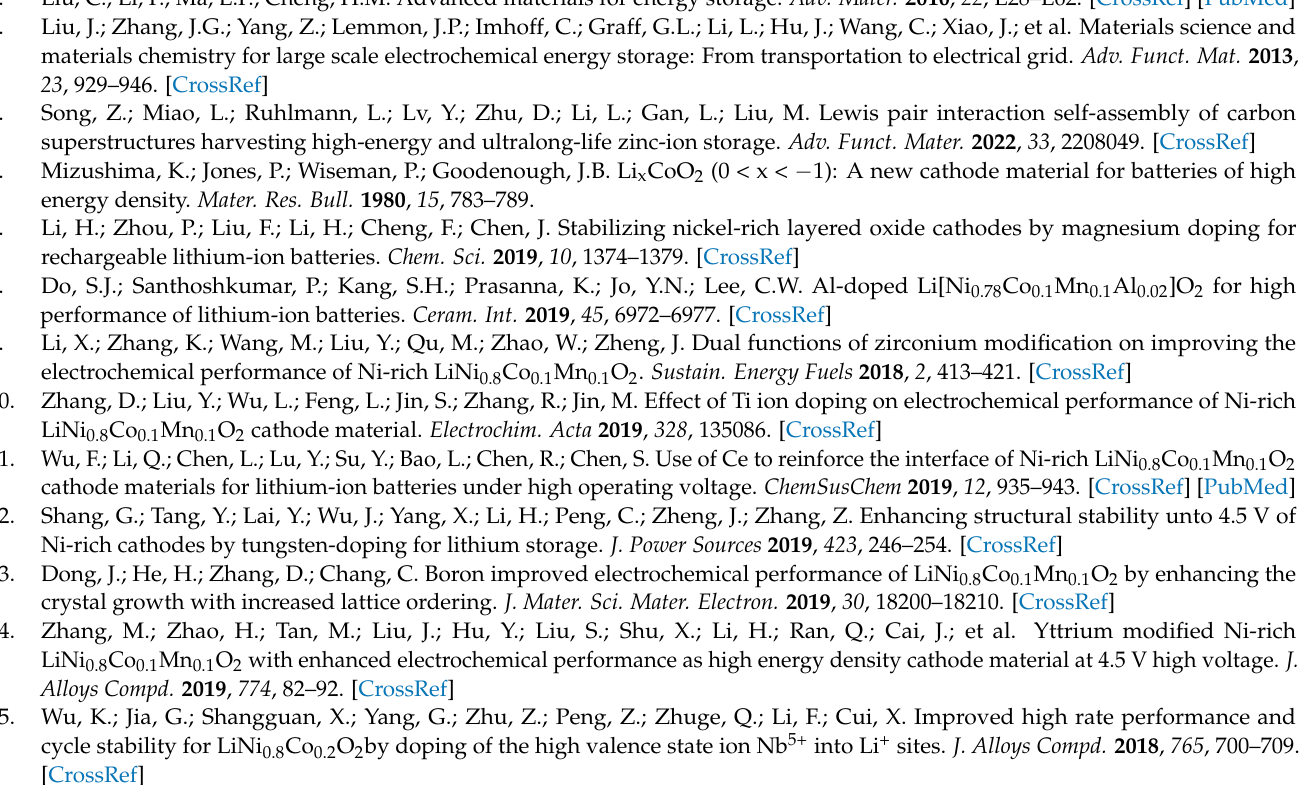
Zr 0.5% cathodes. Figure S7: XPS spectra of (a) Ni 2p, (c) Zr 3d for SNCM-pristine and SNCM-Zr 0.5% cathodes. Figure S8: (a) Schematic picture of bimodal NCM materials, and (b) Particle size distribution data of L100% and (L80% + S20%) bimodal NCM cathode. Figure S9: SEM morphology of bimodal cathode powders at different blended ratio: (a) L90% + S10%, (b) L80% + S20%, (c) L70% + S30%, and (d) L60% + S40%. Figure S10: Specific charge/discharge profiles, and Volumetric charge/discharge profiles of (a,b) L100%, and (c,d) L80% + S20% cathodes under 0.3 C between 2.8 and 4.3 V at room temperature. Table S1: Li/Ni/Co/Mn molar ratios of SNCM samples calcined at different temperatures. Table S2: Electrochemical parameters for cells made with SNCM cathodes. Table S3: Comparison of electrochemical parameters for ZrO 2 -modified NCM cathode